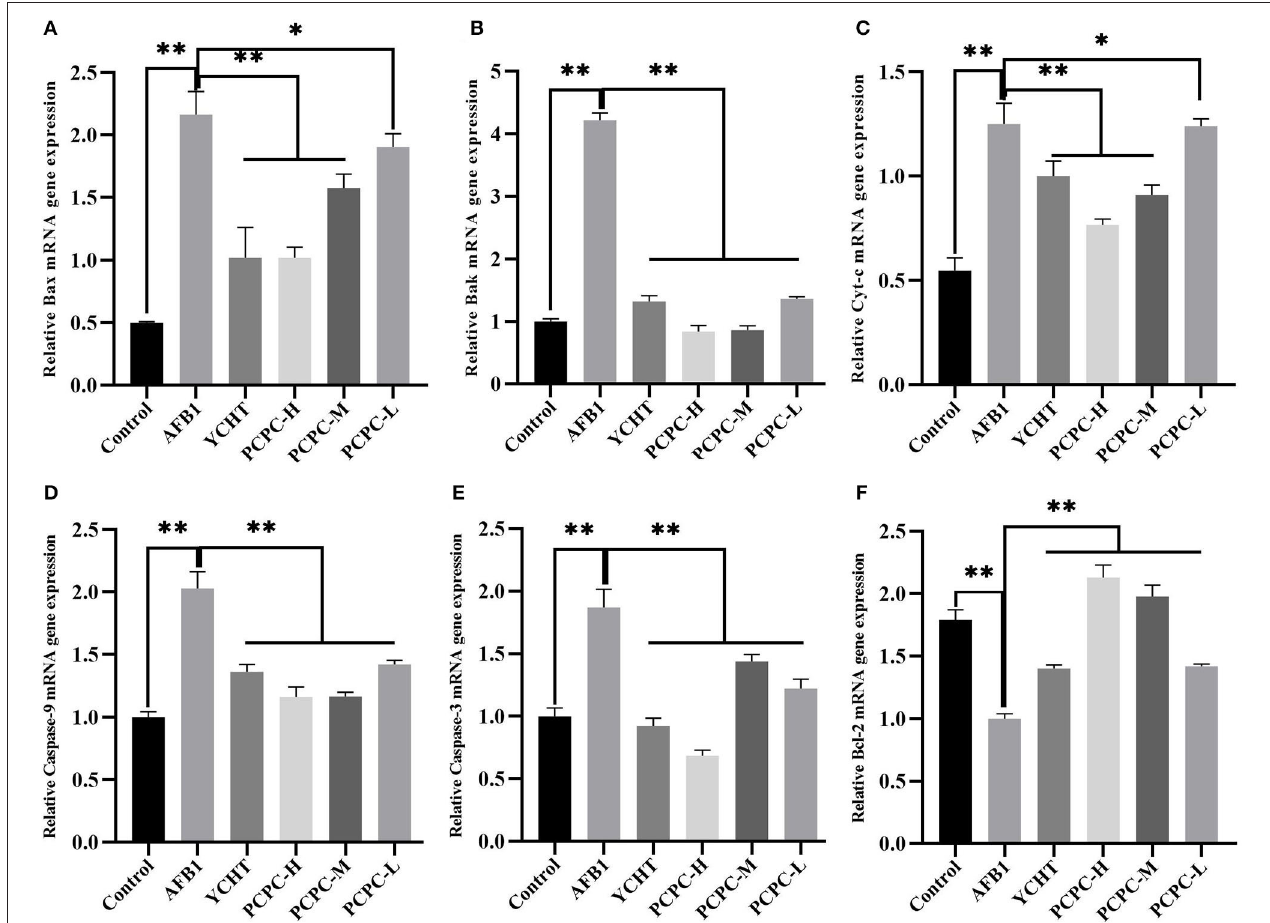
FIGURE 6 | Effect of PCPC and AFB 1 on apoptosis-related genes in the kidney of broilers. The mRNA expression of apoptosis-related genes were identified by quantitative real-time PCR. All data are expressed as means ± SD. (A) Bax; (B) Bak; (C) Cyt-c; (D) Caspase-9; (E) Caspase-3; (F) Bcl-2. Asterisk indicates significant difference ( p < 0.05) compared to the control group and AFB1 group. * p < 0.05 and ** p < 0.01.